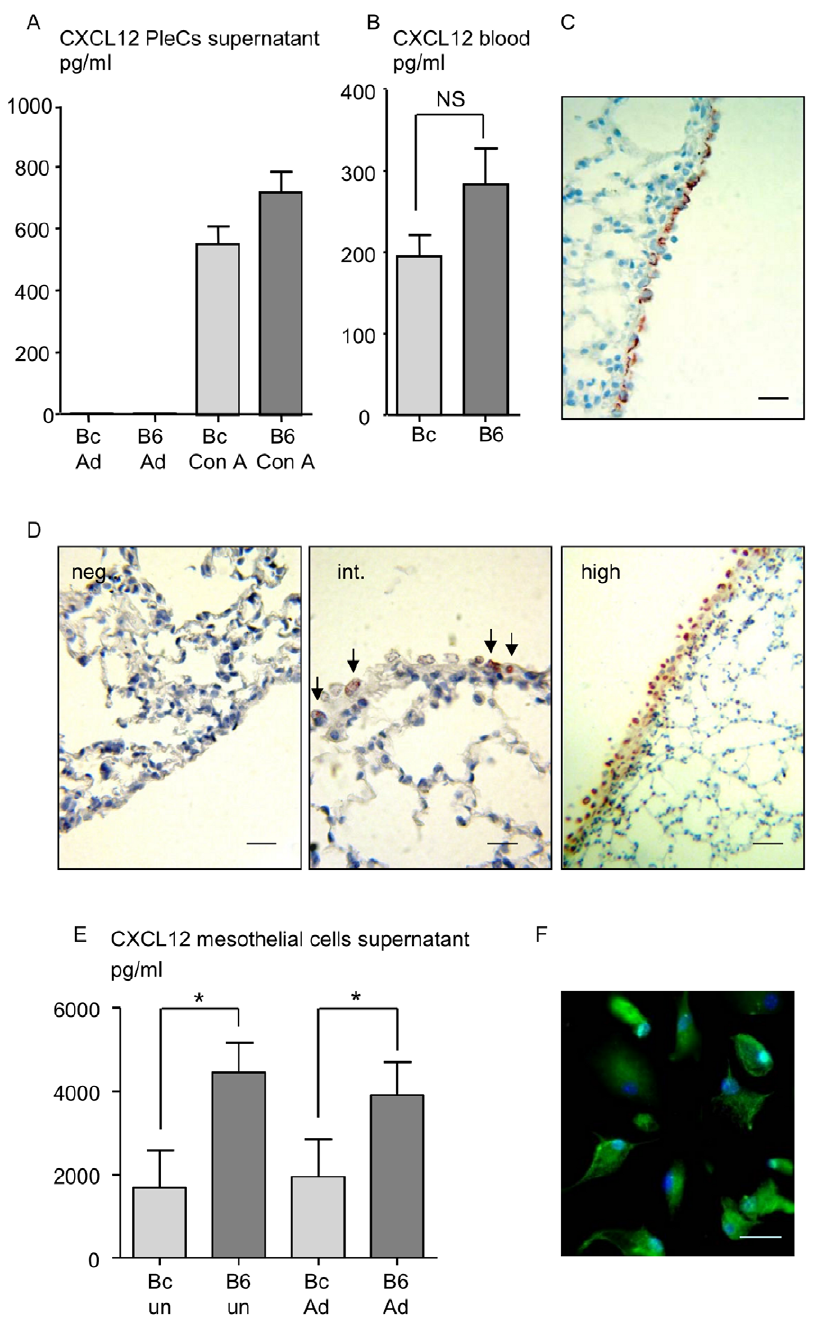
Figure 3. CXCL12 is produced by the mesothelium of C57BL/6 mice. A. Pleural exudate cells (PleCs) were harvested 30 days post-filarial inoculation (p.i.), by PBS washing. The cells were stimulated for 72 hours with crude extract of adult (Ad) L. sigmodontis (10 m g/ml) or with 1 m g/ml of the mitogen Concanavalin A (Con A). Levels of CXCL12 were detected by ELISA (eBiosciences) in the culture supernatant. Results are expressed as mean 6 SEM, 6 mice per group. B. Differential levels of CXCL12 at 30 days p.i. in the sera of BALB/c mice (Bc) and C57BL/6 mice (B6) measured by ELISA. Results are expressed as mean 6 SEM, 6 mice per group; unpaired t-test, non significant (NS). C. Chromogenic immunohistochemical staining with cytokeratine 7 of paraffine-embedded visceral pleural mesothelium sections representative of naive or infected BALB/c and naive C57BL/6 tissues. Scale: bars=20 m m. D. Chromogenic immunohistochemical staining of paraffine-embedded tissue section of C57BL/6 and BALB/c visceral pleural mesothelium: figures are representative of established scores as described in Material and Methods and in Table 1. From left to right: negative (neg.) CXCL12 staining, weak CXCL12 staining (int. for intermediate), high CXCL12 staining (high). Same results were observed with the two antibodies tested (polyclonal antibody, 1:500, eBioscience; biotinylated clone K15C, 1:200). Scale: bars=20, 10, 40 m m. E. Differential levels of CXCL12 in mesothelial cell supernatants was measured by ELISA. Mesothelial pleural cells were harvested by trypsine digestion from 12 BALB/c mice and 12 C57BL/6 mice 30 days post-filarial inoculation. Once at 70% of confluence, half of the cells were stimulated for 48 hours with crude extract of adult L. sigmodontis (10 m g/ml, groups Bc Ad and B6 Ad). Unstimulated cells were also tested (Bc un and B6 un). Detail of culture conditions is provided in Material and Methods. Results are presented after subtraction of the baseline production as a barplot showing medians and range. The differences between strains were analysed by a Kruskall-Wallis test followed by a Dunn’s multiple comparison test. ‘‘*’’ represents significant differences between the C57BL/6 mice and the BALB/c mice. F. Fluorescent immunological staining of CXCR4 on mesothelial cells culture. Scale: bars=15 m m.